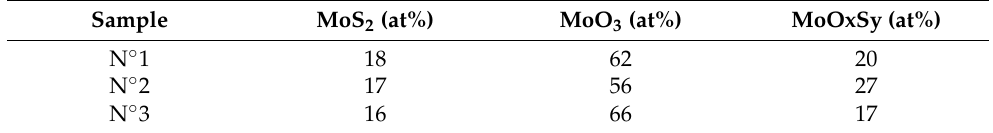
Table 3. Atomic percentages extracted from Mo 3d XPS spectra of the components present in the MoO 3 :MoS 2 hybrid thin film after 10 min of reaction in the darkness, the H 2 O 2 concentration being 3%.